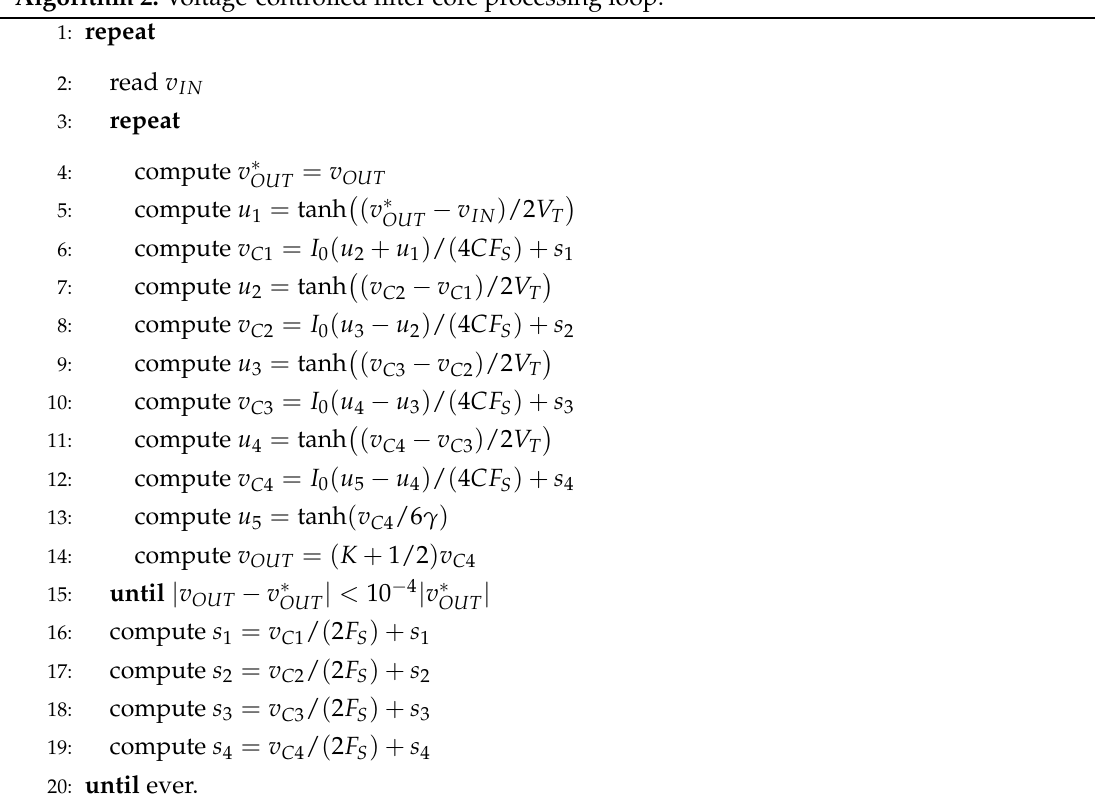
Algorithm 2: Voltage-controlled filter core processing loop.